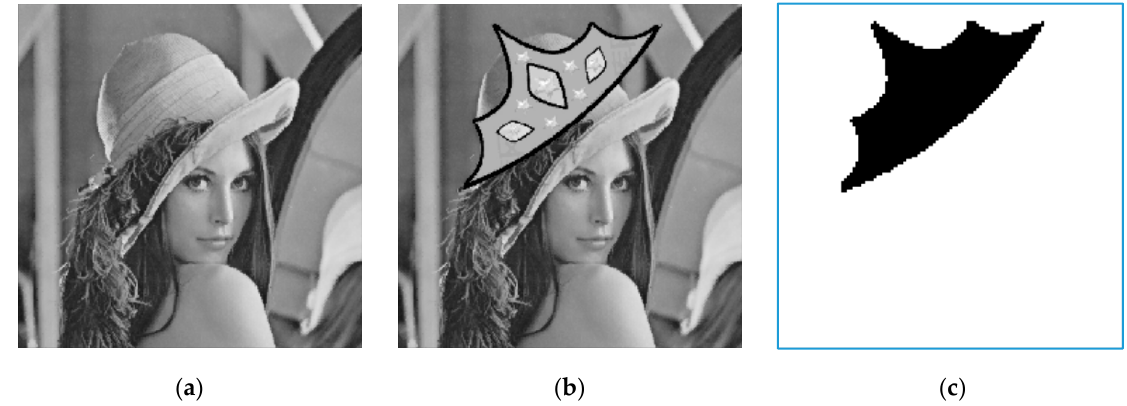
Figure 6. The tampered Lena image. ( a ) Marked image; ( b ) Tampered image; ( c ) Tampered region.